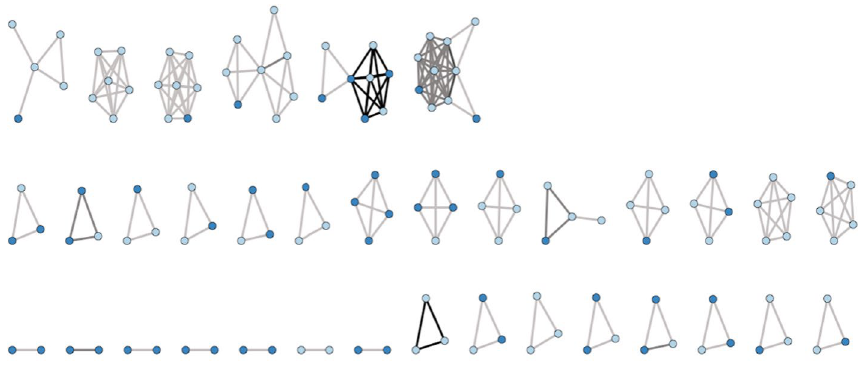
Fig. 2 REDES Journal’s co‑authorships. Source: Elaborated by the authors using the database of this research